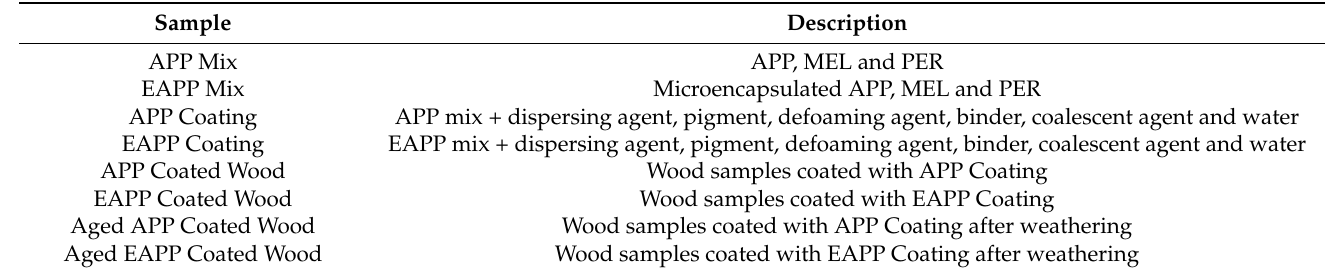
Table 2. List of intumescent blends and coatings used in this